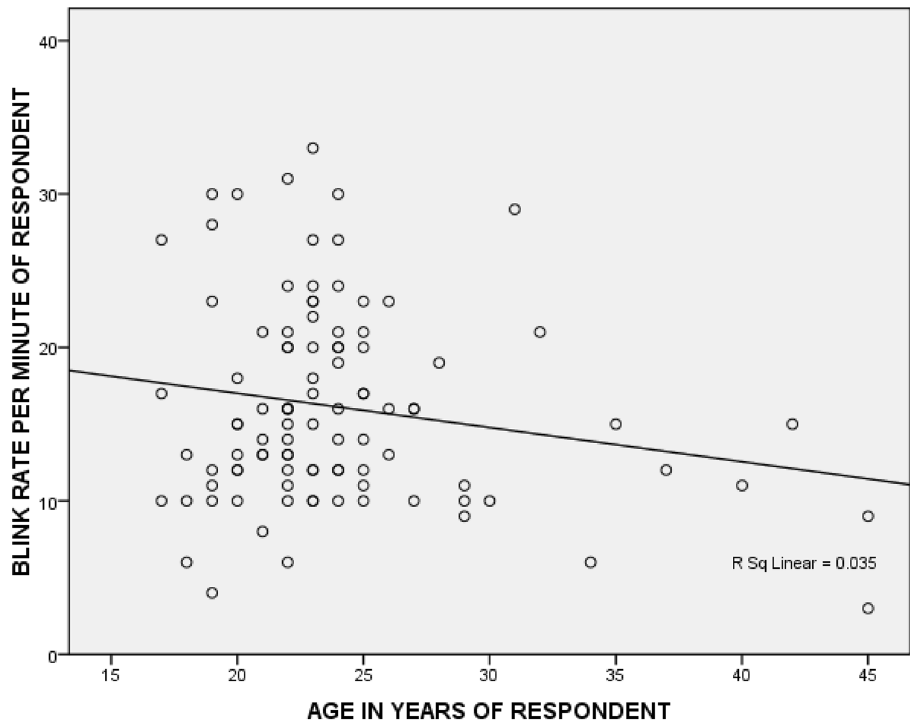
Figure 1. Correlation between age and blink rate.